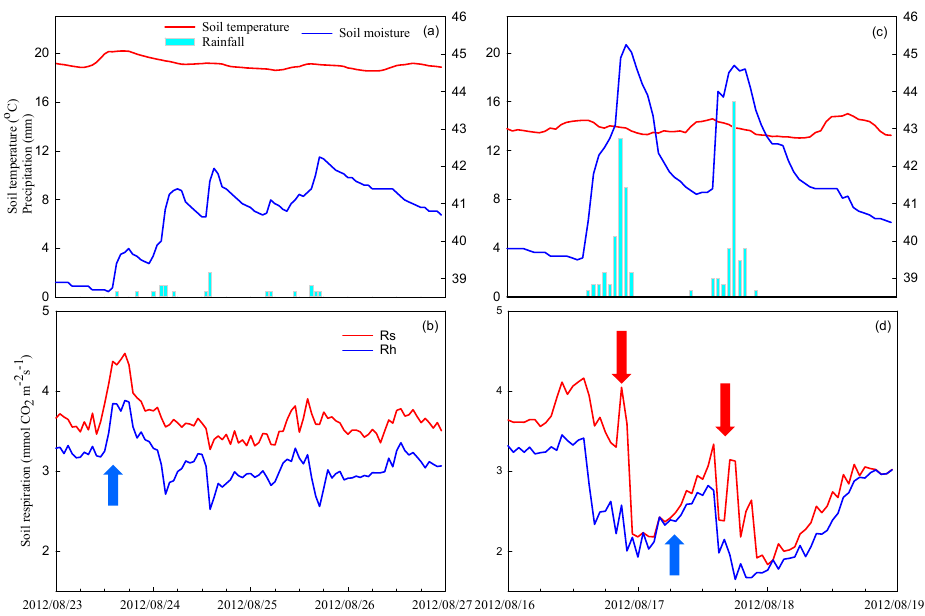
Figure 6. Hourly environmental factors ( a , c ) for soil temperature, soil moisture and rainfall. Pulse increases and decreases in soil respiration data were related to normal ( a , b ) and strong ( c , d ) rainfall events. The blue arrows in ( b ) and ( d ) represent pulse increases in respiration, while the red arrows in ( d ) represent pulse decreases in soil respiration caused by strong rainfall events.